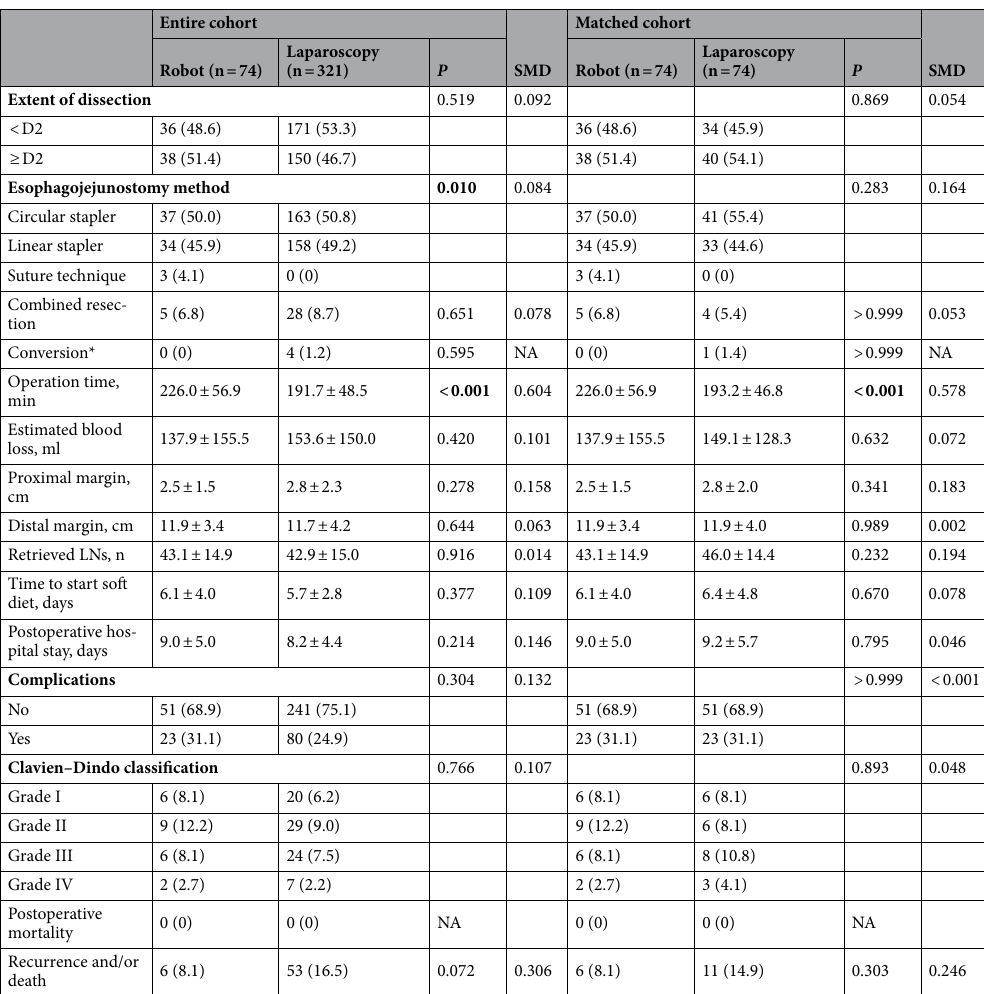
Table 2. Operative outcomes before and after propensity score matching. Statistically significant values ( P < 0.05) are given in bold. Data are expressed as means ± standard deviations or as n (%) unless otherwise specified. SMD standardized mean difference, LNs lymph nodes, NA not applicable. * Conversion to laparoscopic or open surgery in the robotic group and conversion to open surgery in the laparoscopic group for any